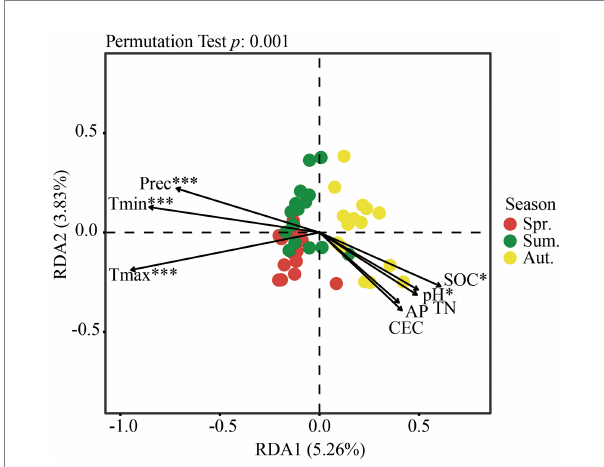
FIGURE 6 Redundancy analysis (RDA) of fungal communities at the OTU level and environmental variables. The envfit function was used to test the significance of each physicochemical factor in RDA. * p < 0.05; *** p <